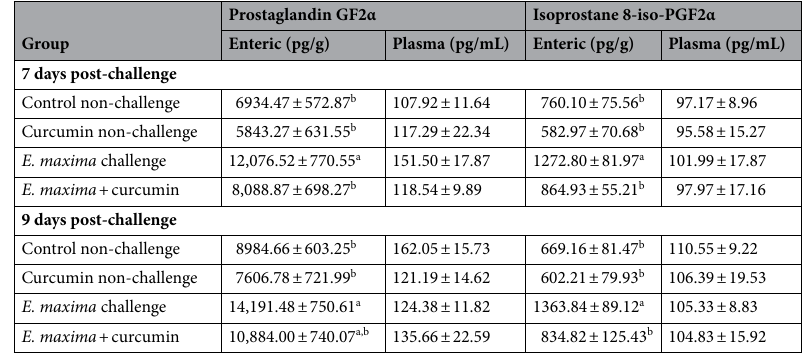
Table 2. Evaluation of isoprostane 8 ‐ iso ‐ PGF2α and prostaglandin GF2α from enteric (jejunum) and plasma of specific pathogen-free Leghorn chickens at 7- and 9-days post-challenge. Data expressed as mean ± standard error. a,b Different superscripts within columns and days indicate a significant difference at P < 0.01.